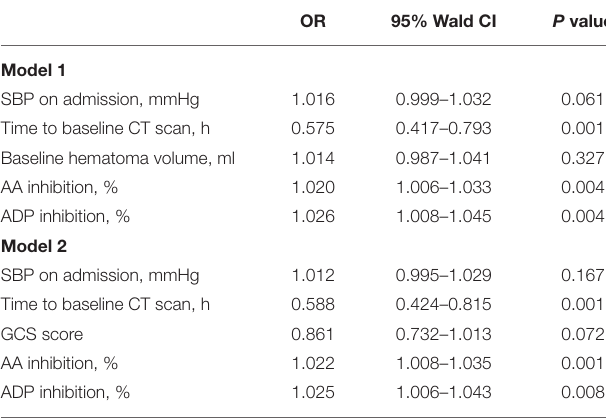
TABLE 2 | Multivariate analysis of predictors for hematoma expansion.